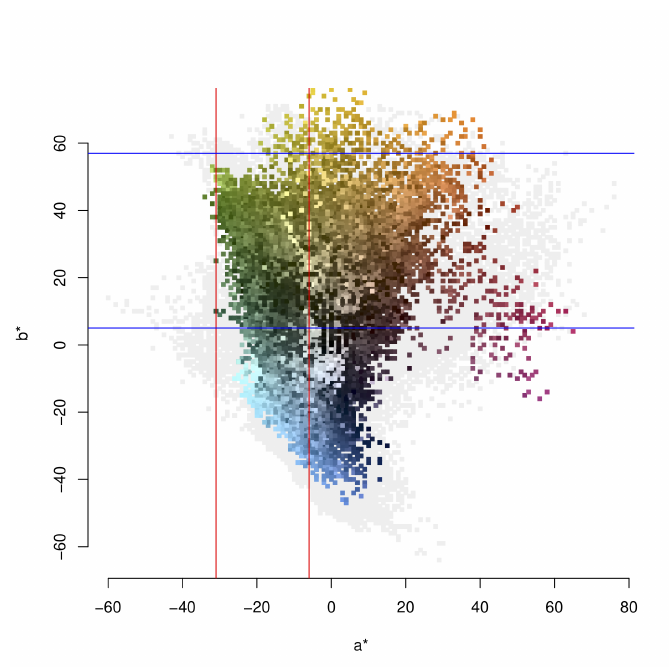
Figure 4. Vegetation (coloured region) and non-vegetation pixels (grey) in the Mapillary dataset. Each point represents an individual pixel from a randomly sampled set of images from the dataset. Pixels are coded according to the colour represented by the a ∗ b ∗ pair. The sample includes values with varying patterns of L ∗ (lightness), and as such exhibits wide variability. Only pixels belonging to the vegetation class are retained, with the remaining classes colour coded as grey on the background to illustrate the overall feature space. The vertical lines extending from the a ∗ axis correspond to the optimal A 1 (left), A 2 (right) parameters, while the horizontal lines extending from b ∗ represent the optimal B 1 (bottom), B 2 (top)